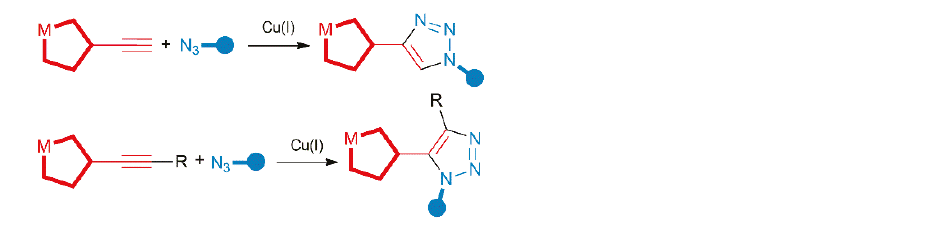
Scheme 1. Schematic representation of CuAAC reaction between functionalized metal complex and substituted organic azide.